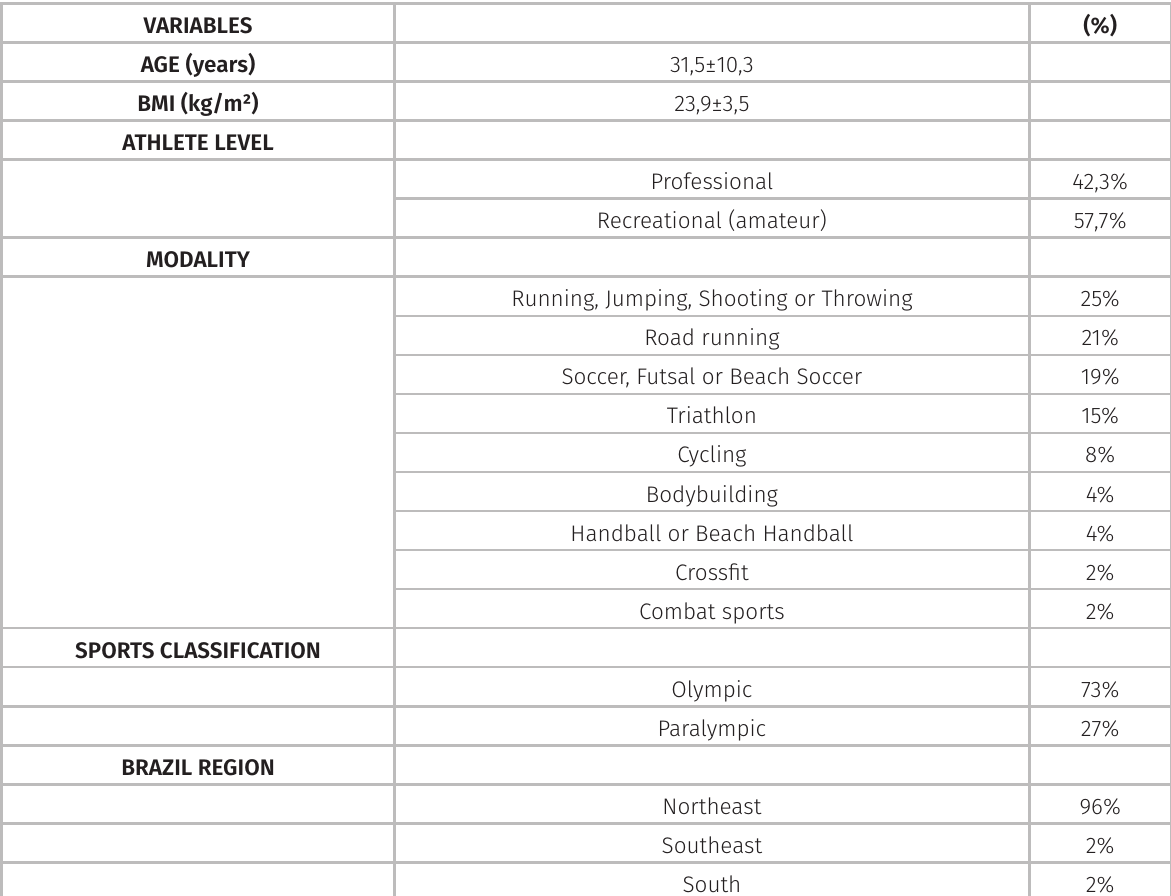
Table I. Demographic characteristics of